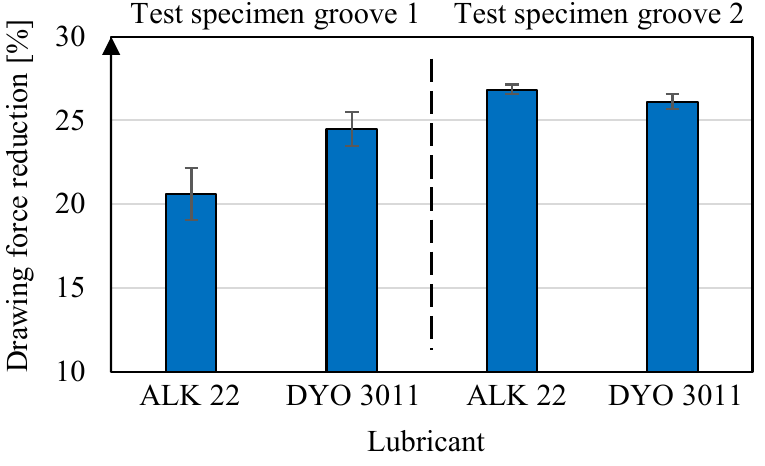
Figure 19. Percentage reduction in drawing force for different lubricants and grooves.